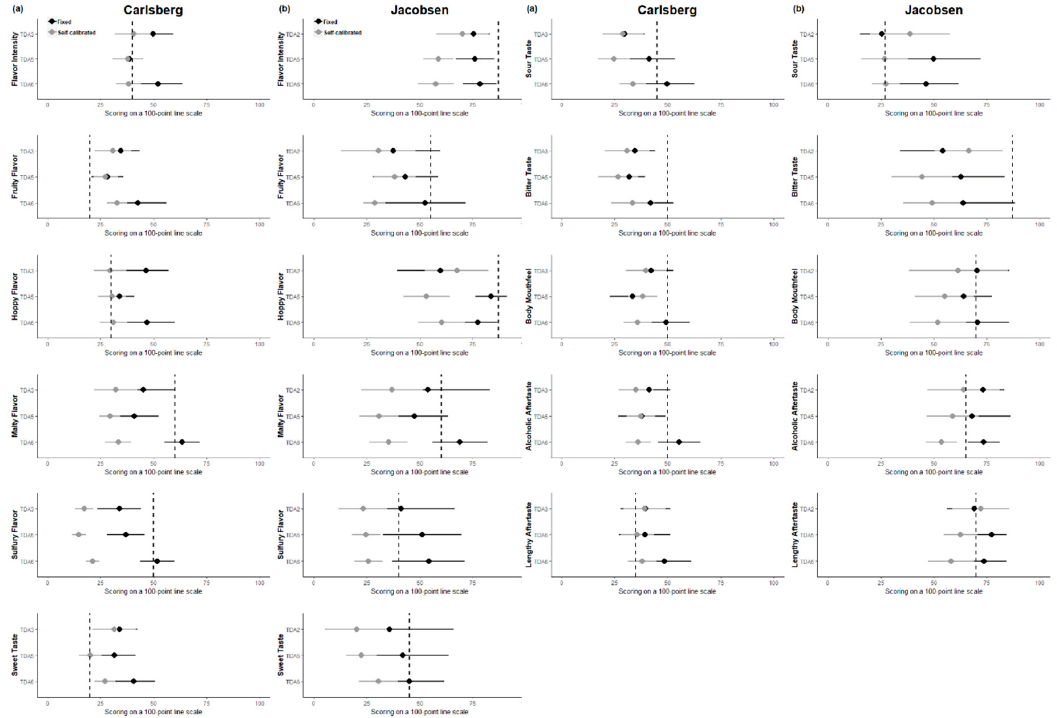
Figure 6. Performance progression (mean scores and confidence intervals) compared to the target value (dashed line), over training sessions TDA 2–6 for ( a ) the Carlsberg sample and ( b ) the Jacobsen sample. Data are averaged over panelists and replicates.